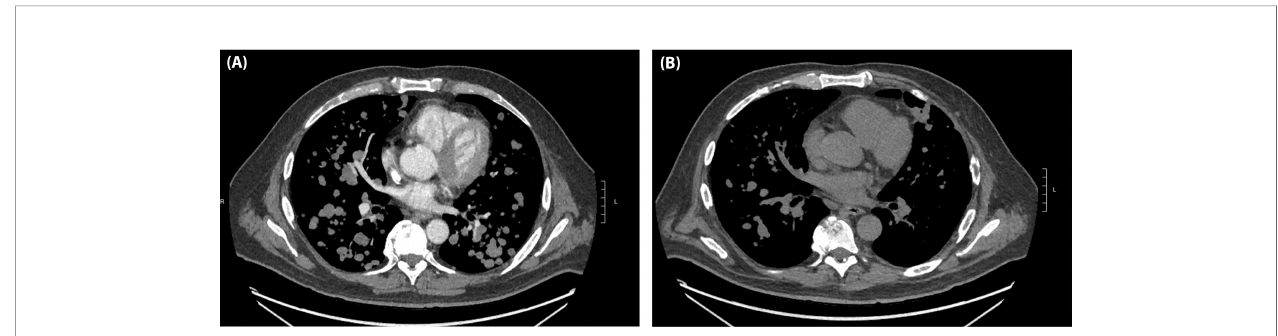
FIGURE 3 | A 52-year-old man with BRAF-wildtype, metastatic melanoma with lung, liver, spleen, and brain involvement who received dose 1 of ipilimumab/ nivolumab on 11/15/19 and dose 2 on 12/03/19. (A) Baseline CT chest on 11/06/19 and (B) CT chest on